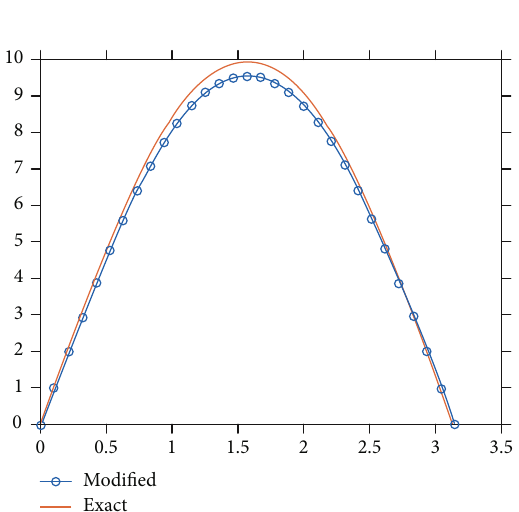
Figure 5: The disparity between the exact solution of the system of equations (2) – (5) and the regularized solution of the system of equations (12) – (15) for p = 1 and k = 0 : 5 .